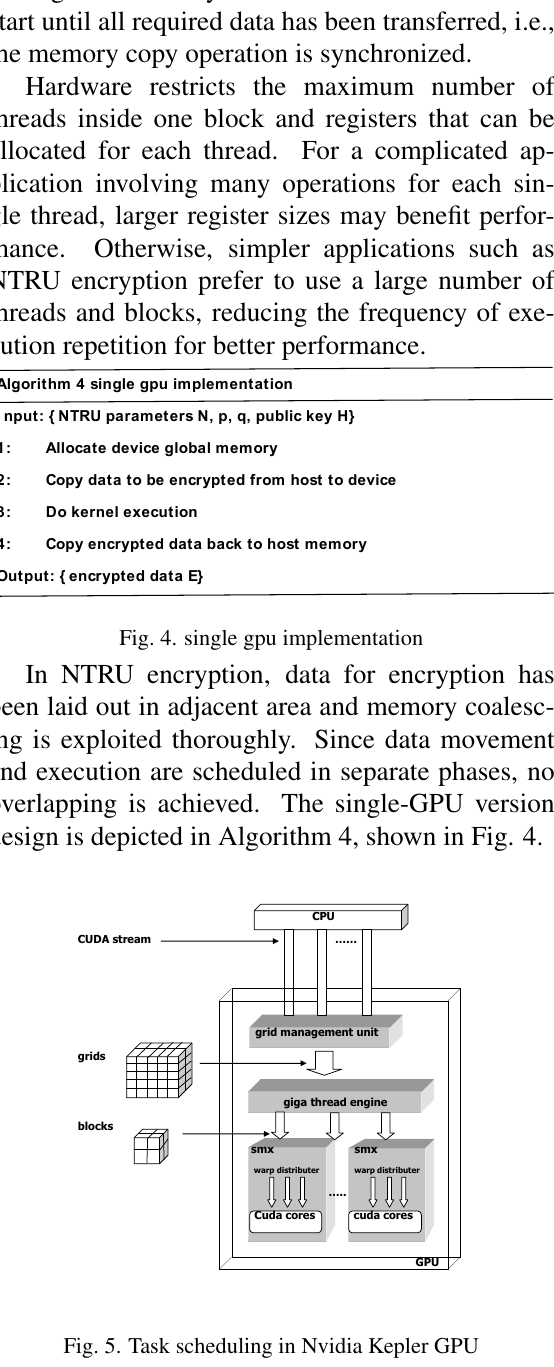
Fig. 5. Task scheduling in Nvidia Kepler